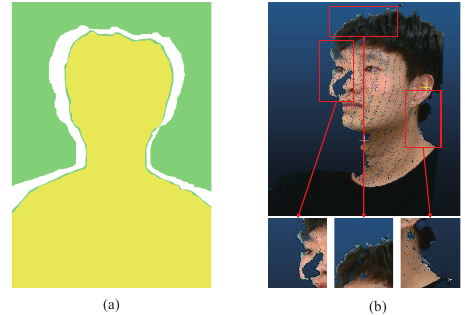
Figure 1. Edge noise at discontinuities in the depth domain. ( a ) Schematic diagram of edge noise. The green area is the background and the yellow area is the foreground. The white area is the depth discontinuity area where the foreground and background are separated, and the green area attached to the outer contour of the yellow foreground is the edge noise, which is caused by the depth camera measurement principle. ( b ) Visualization of edge noise on a point cloud of real data. The detailed image of the edge noise is contained in the red